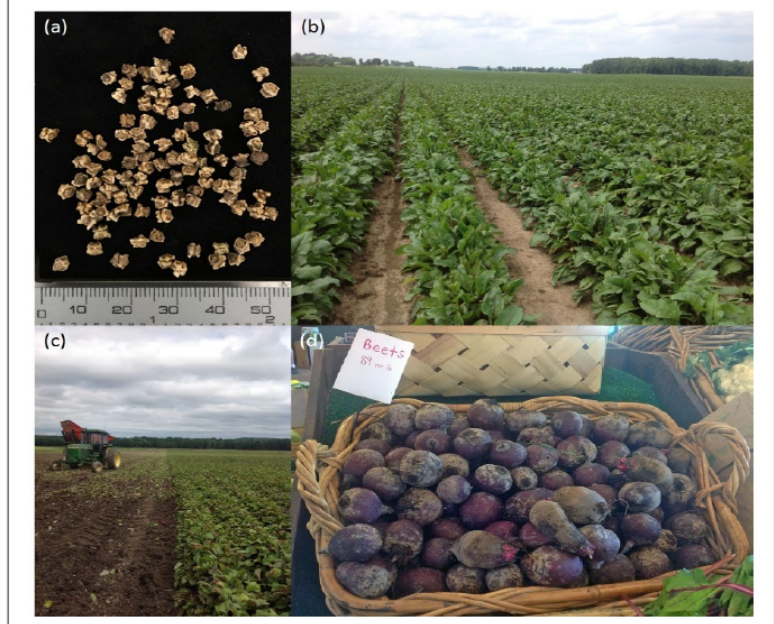
Figure 1. Parts of table beet cultivation in New York, including ( a ) Seed used to establish root crops; ( b ) Healthy foliage at approximately mid-season (~late July); ( c ) Harvest results in the roots being removed from the ground and return of the tops to the field; and ( d ) Washed table beet roots with the foliage removed for sale at a local market.